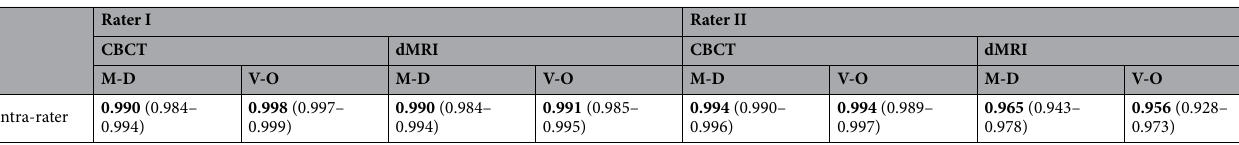
Table 1. Intra-rater ICC and 95% confidence interval of CBCT and dMRI canal length measurements in the mesio-distal (M-D) and vestibulo-oral (V-O) directions. Significant values are in bold.